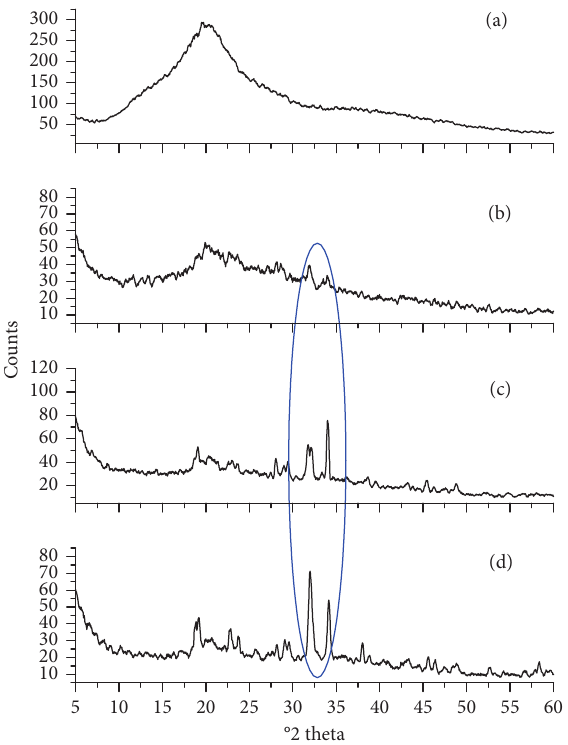
Figure 3: XRD spectra of (a) Chitosan, (b) CGPNMA, (c) CGP2MA, and (d)